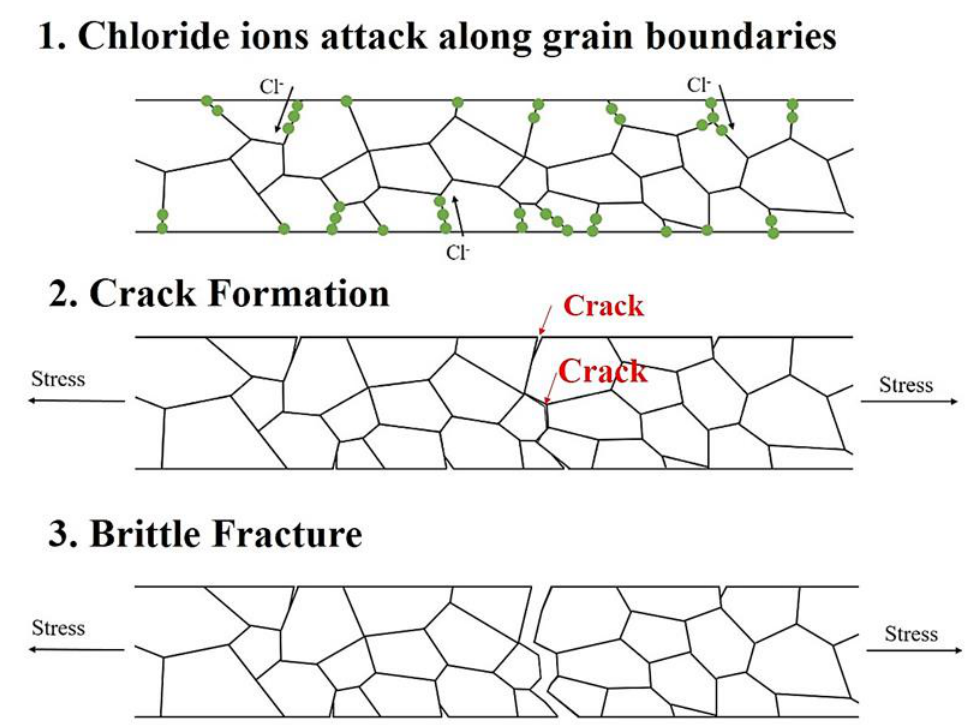
Figure 5. Energy dispersive spectroscopy (EDS) element analysis results of the crack.